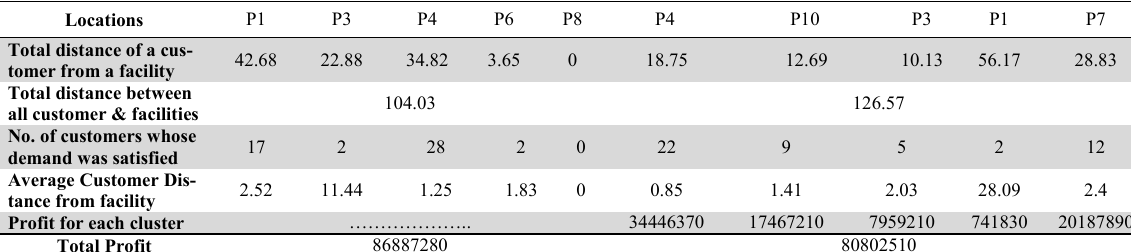
Number of clusters = 5